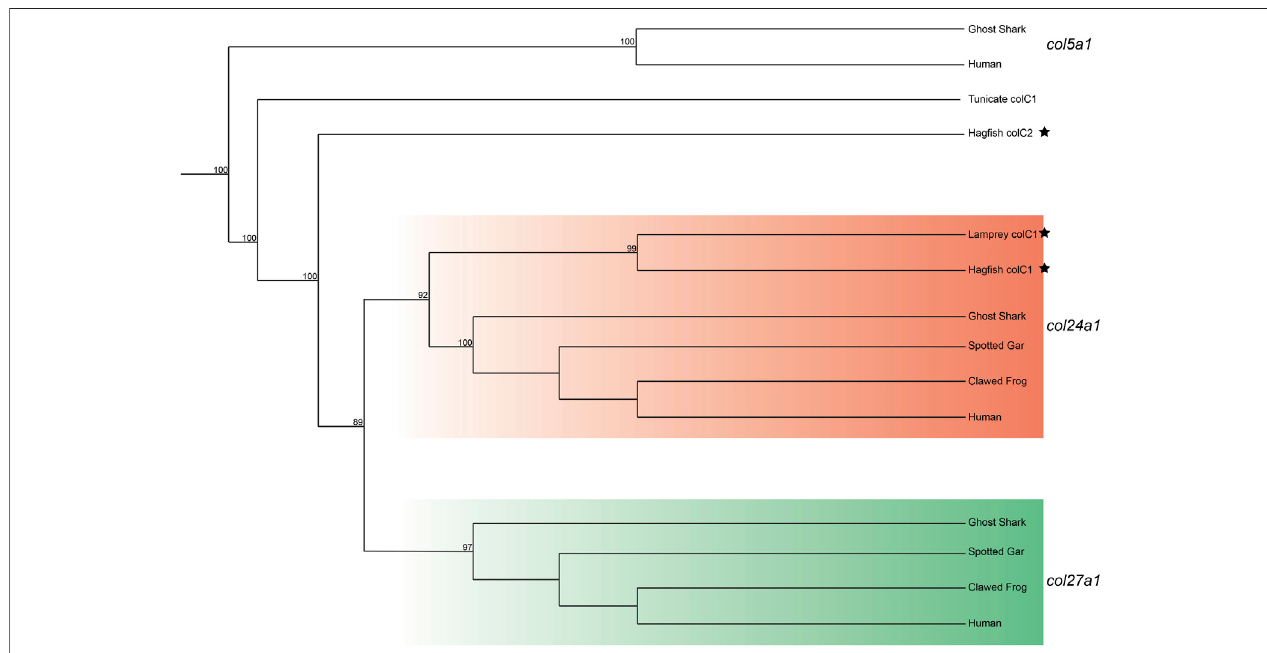
FIGURE 4 | Recreated phylogenetic tree built from vertebrate and tunicate Clade C fi brillar collagen sequences. Maximum likelihood analysis scores are shown at therespectivenode.Thehumanandghostshark col5a1 geneswerechosenasthemostrelevantoutgroup.Cyclostomegenesarelabelledwithablackstar.Originaltree can be found in Supplementary Figure S6 . Accession numbers for all sequences can be found in Supplementary Table S7 .